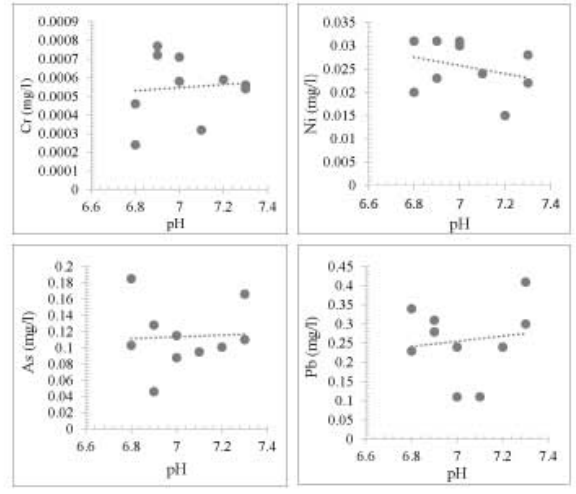
Figure 4: Binary plots of pH vs the trace metals